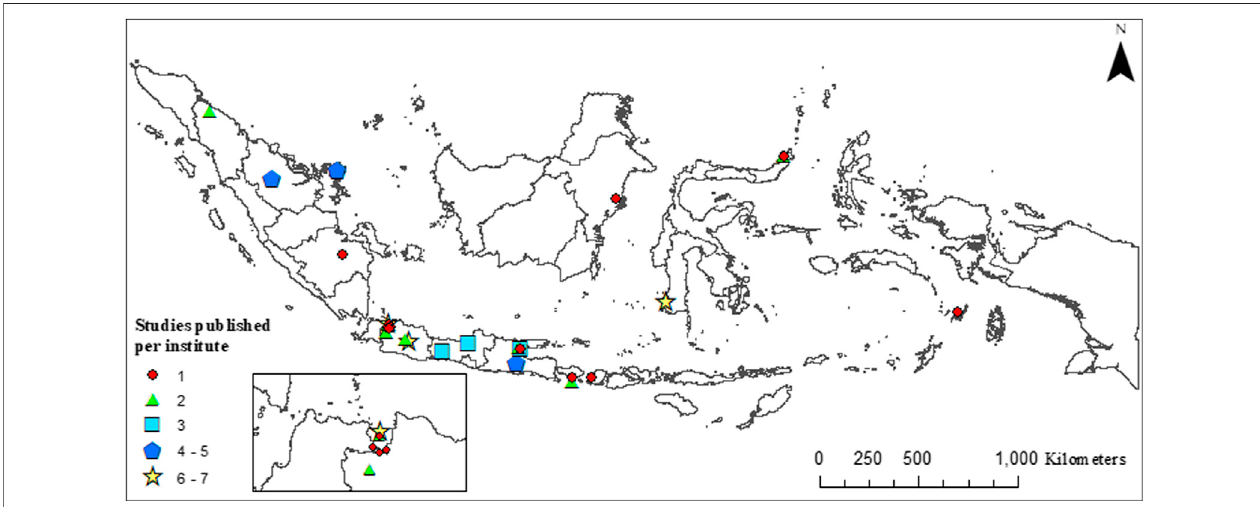
FIGURE3| LocationofinstitutesthatpublishedonplasticpollutioninIndonesia,andthenumberofpublicationsthey(co-)authored,whereredcirclesindicateone study, green triangle represents two studies, blue square represents three studies, blue pentagon represents four to fi ve studies, and the yellow start represents six to seven studies (co-) published per